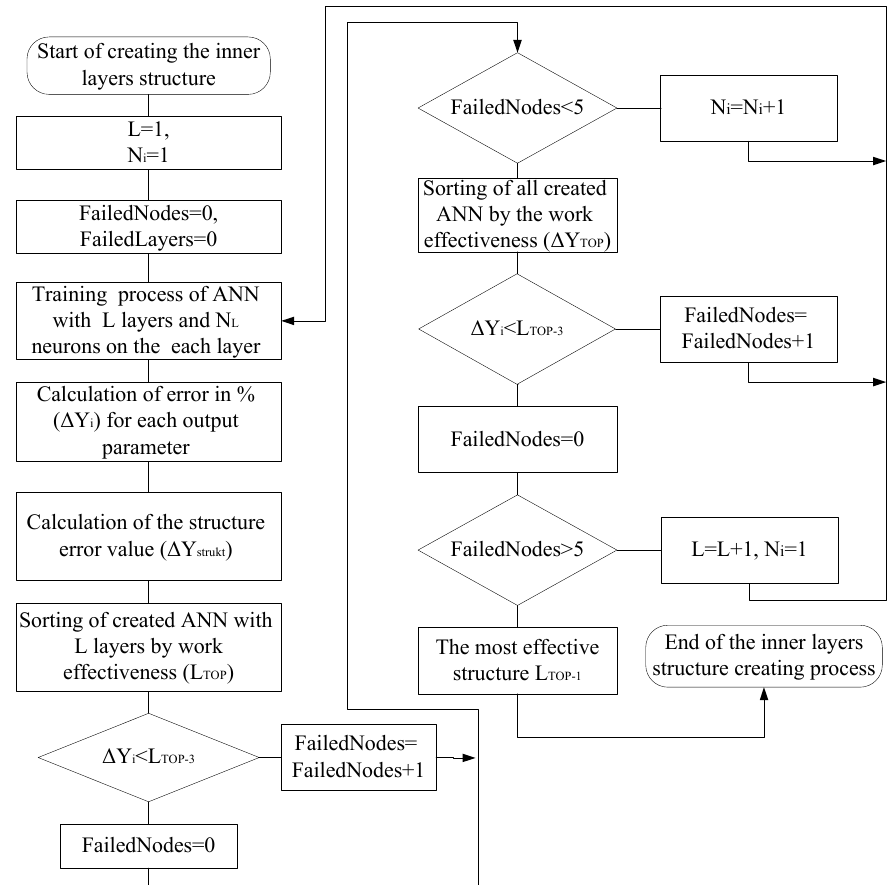
Figure 3. A block diagram of the algorithm for creating the ANN’s inner layers’